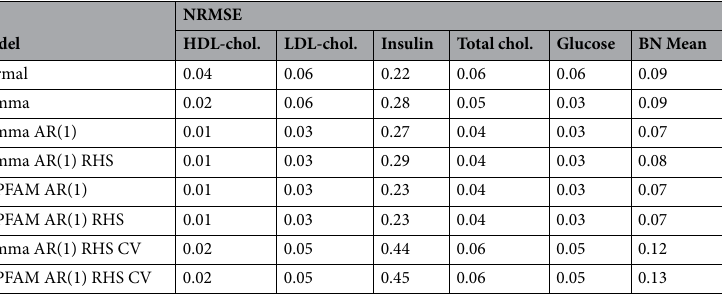
Table 1. Comparison of model candidates. Model candidates were compared with a normalized root mean squared error (NRMSE) separately for each concentration and with mean accuracy of the whole